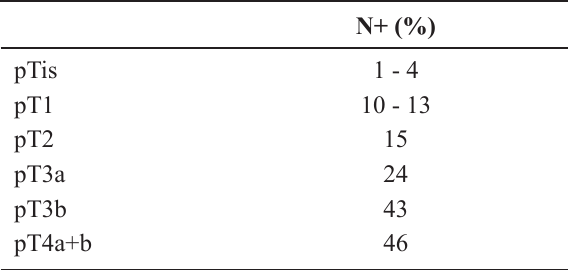
Table 2 – Incidence of histologically proven positive lymph nodes (N+) at various pathological T-stages